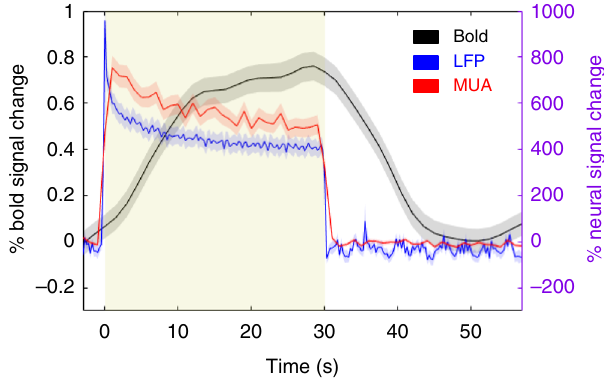
Fig. 3 Responses to innocuous tactile stimulation of digits in the spinal cord. Overlay of averaged time courses of fMRI (black), LFP (blue), and MUA (red) responses in the ipsilateral dorsal horn. Shaded yellow region and error bars represent stimulus-on period and standard error of mean, respectively. LFP signals are represented with computed r.m.s. (bin size = 0.25 s, no overlap, N = 4 monkeys, n = 40 runs), while MUA is presented as spike rates (bin size = 1 s, no overlap, N = 2 monkeys, n = 24 runs). Percentage signal changes for BOLD and neural signal were computed relative to the pre-stimulus period; BOLD and electrophysiological signals are plotted against the y-scale on the left (black) and right (purple), respectively. It is also important to note that signals from the two modalities were not acquired